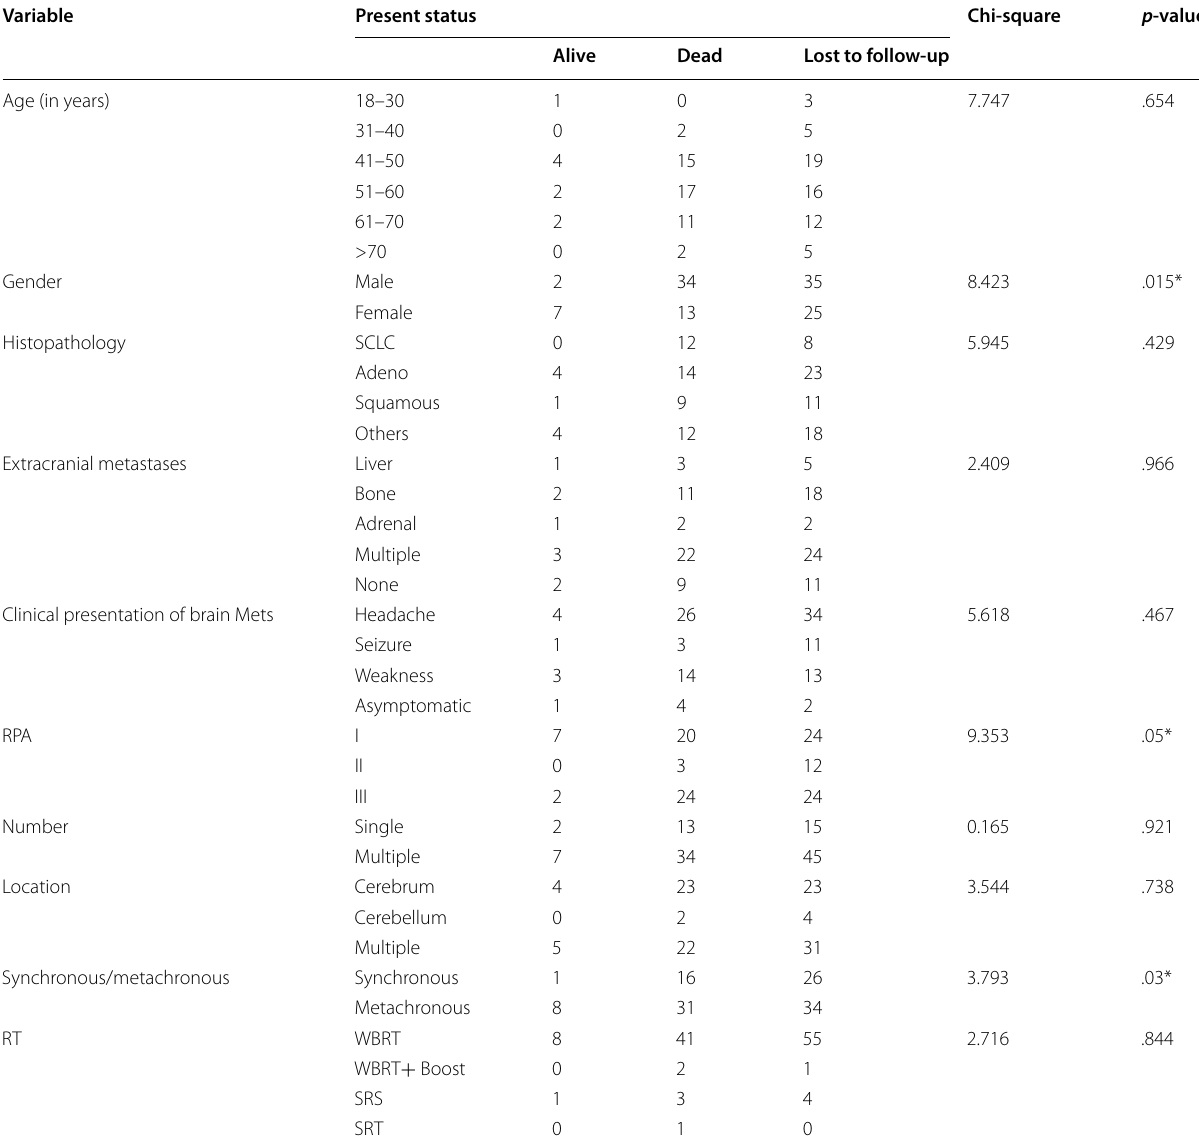
Table 3 Correlation of factors with survival in BM